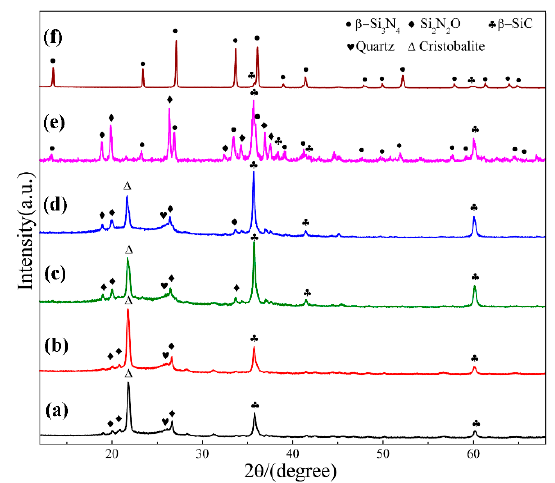
Figure 2. XRD patterns of sample S1 nitrided at different temperatures for 3 h: ( a ) 1470 °C; ( b ) 1500 °C; ( c ) 1530 °C; ( d ) 1550 °C; ( e ) 1570 °C; ( f ) 1600 °C. Table 2. Lattice parameters and cell volume of β -Si 3 N 4 in S1 & S5.